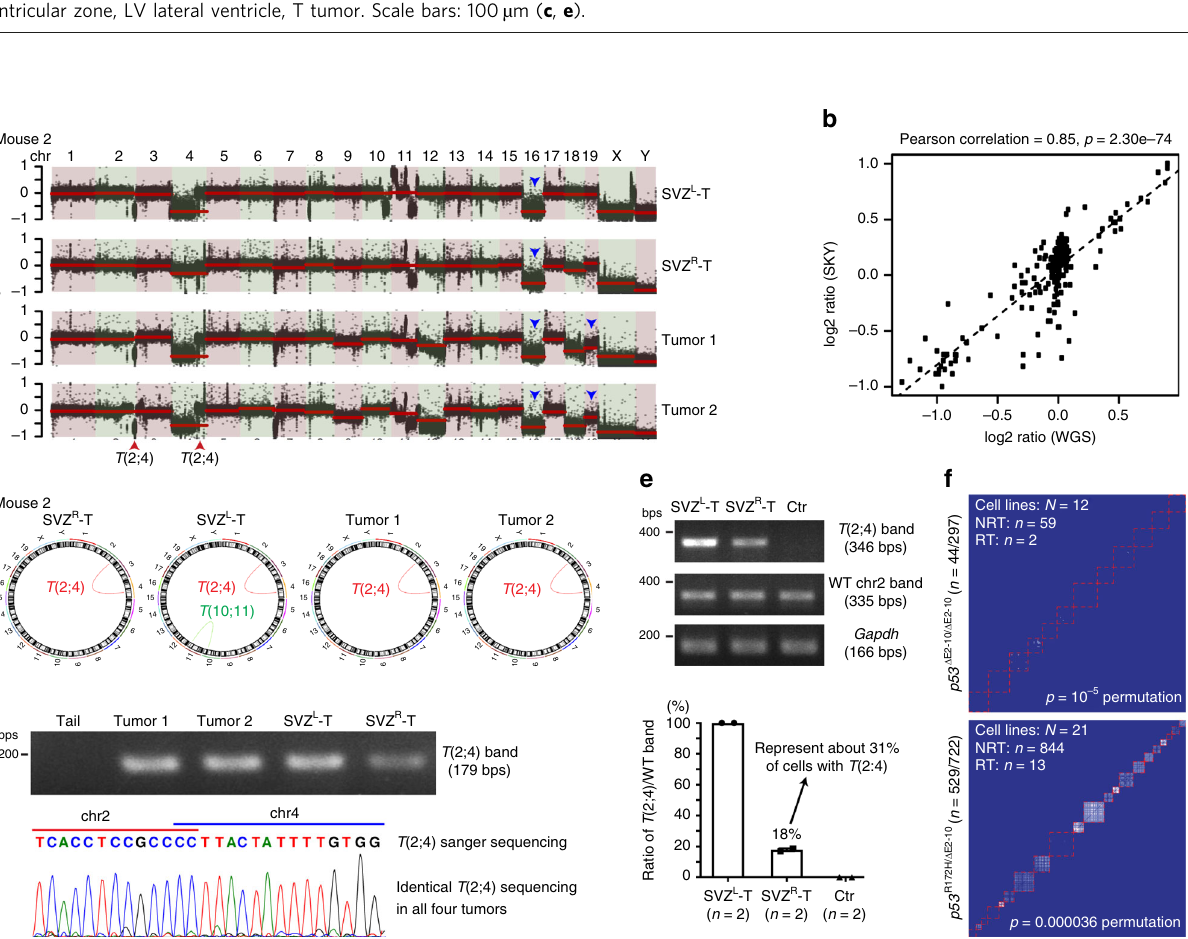
Fig. 3 Spatial segregation in tumor initiation and manifestation in Type 2 cases. a Ploidy and chr19 status at the single-cell level for early passage cNRT 2N -bearing cells derived from paired SVZ tissues and parenchymal Type 2 tumors are shown. Dashed red boxes indicate cNRT 2N -bearing cells with near-2N genomes and normal Pten /chr19. b Western blot reveals Pten in early passages of cell lines derived from paired SVZ tissues and parenchymal tumors. * indicates samples harboring Pik3ca H1047R mutation. Red lines indicate samples isolated from the same tumor masses. Red arrows indicate tumors identi fi ed with chr19 loss by SKY and/or chr19 FISH assay. Case L18 contained four copies of chr19. Source data are provided as a Source data fi le. c Matched Pten and p-S6 labeling in four spatially segregated tumors in Mouse 2. d Immunohistochemical staining of Pten and p-S6 in the SVZ niche and parenchymal tumors of Type 2 cases from the p53 R172H CKO model were qualitatively scored. e Representative images show H&E (left) and Olig2 (middle) staining of parenchymal tumors and SVZ regions in Mouse 6. The boxed areas in SVZ regions are shown at high magni fi cation (right). f Proliferation index measured by the percentage of Ki67 + cells in the SVZ regions and brain parenchymal tumors were compared. * indicates samples harboring Pik3ca H1047R mutation. The frequency of non-clonal NRTs (non-cNRTs) ( g ) and NRTs ( h ) was compared in spatially segregated SVZ- and parenchyma-derived Type 2 tumors and Type 1 tumors. Dashed red lines marked Type 2 SVZ tumors with relatively stable genomes (2N). i Proposed tumor evolution patterns in Type 1 (top) and Type 2 (bottom) cases with de fi ned Pten /chr19 and ploidy status. Data are presented as a dot plot with mean ± SEM. Unpaired, two-tailed Student ’ s t test was used for statistical analysis in ( f , g , h ). * p < 0.05, ** p < 0.01, *** p < 0.001. SE short exposure, LE long exposure, CTX cortex, SVZ subventricular zone, LV lateral ventricle, T tumor. Scale bars: 100 µ m ( c , e ).